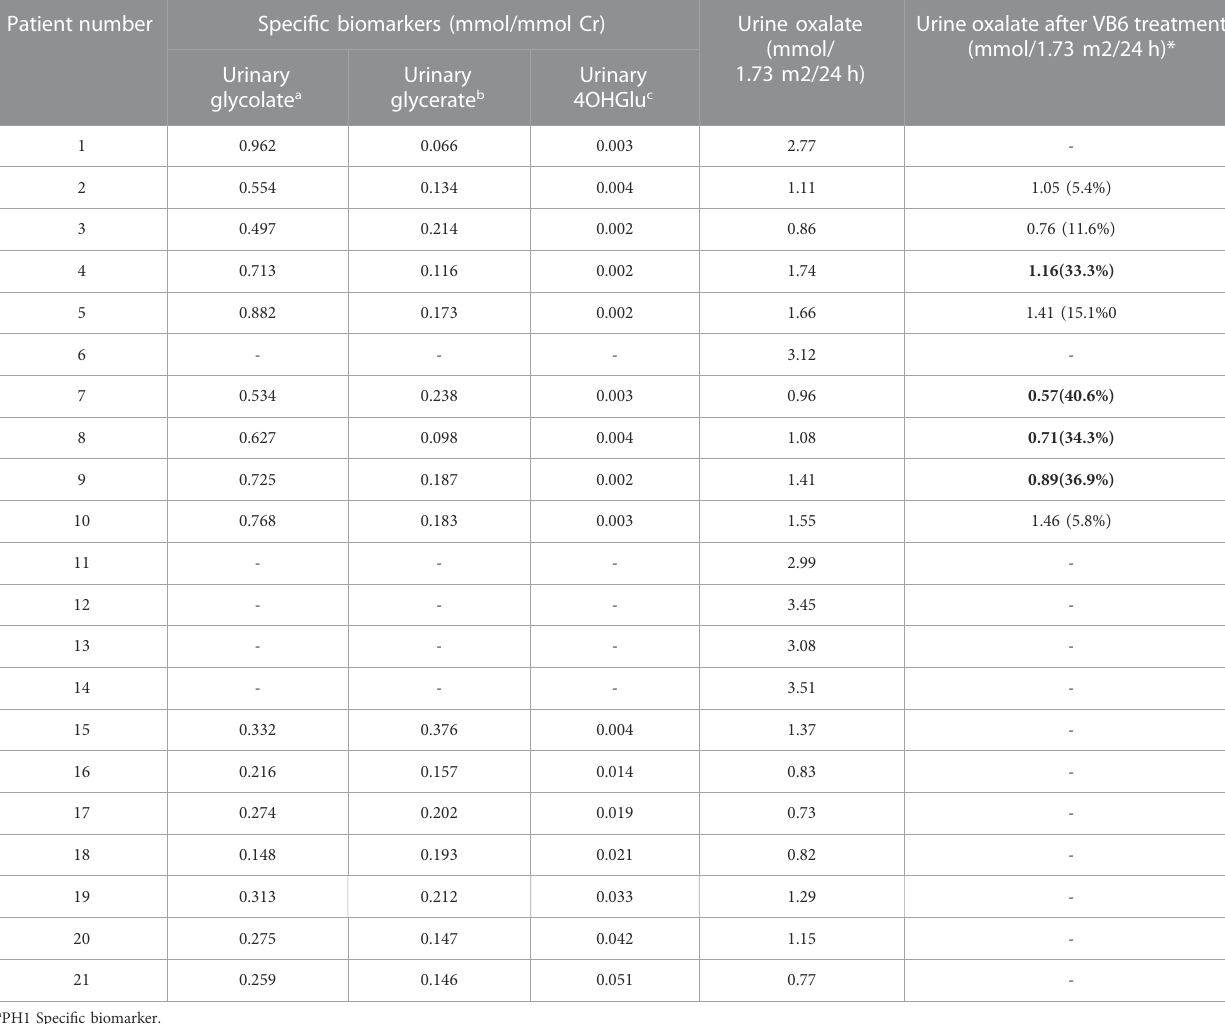
TABLE 4 Analysis of urine organic acid components. Patient